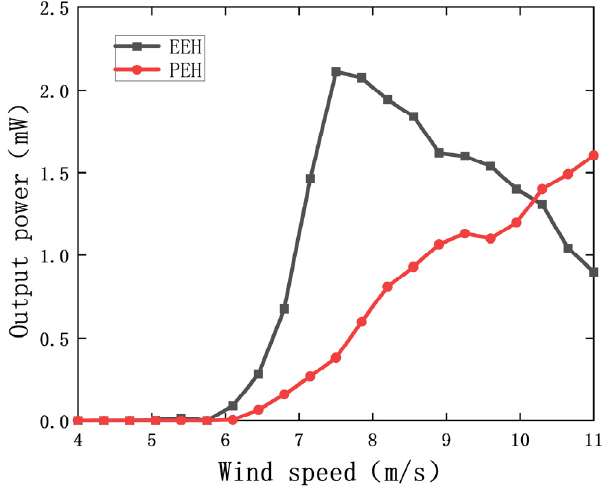
Figure 6. Output power curve of the PEH and the EEH with wind speed.